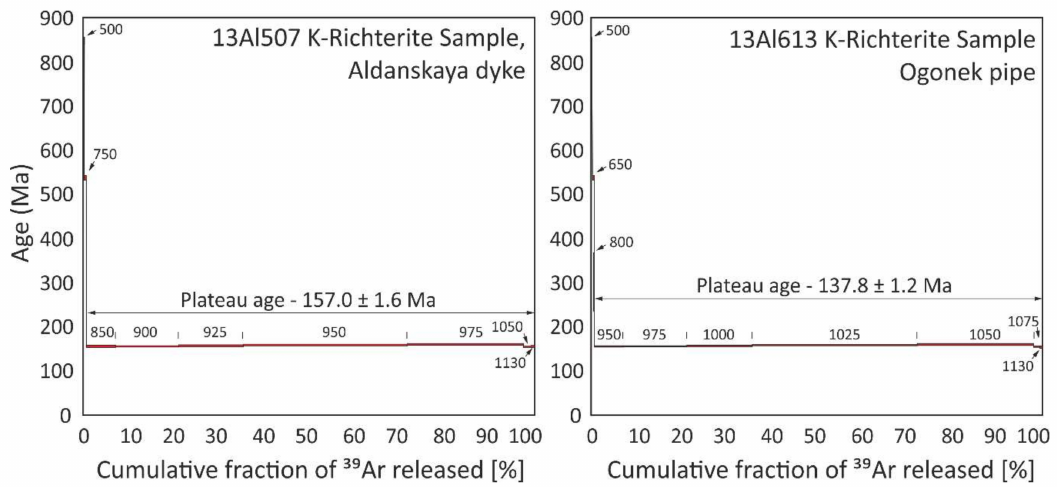
Figure 3. 40 Ar– 39 Ar plateau ages of K-Richterite (13Al507 and 13Al613) samples from Aldanskaya and Ogonek alkaline rocks of Chompolo field. The temperatures for each step of heating are shown ( ◦ C).